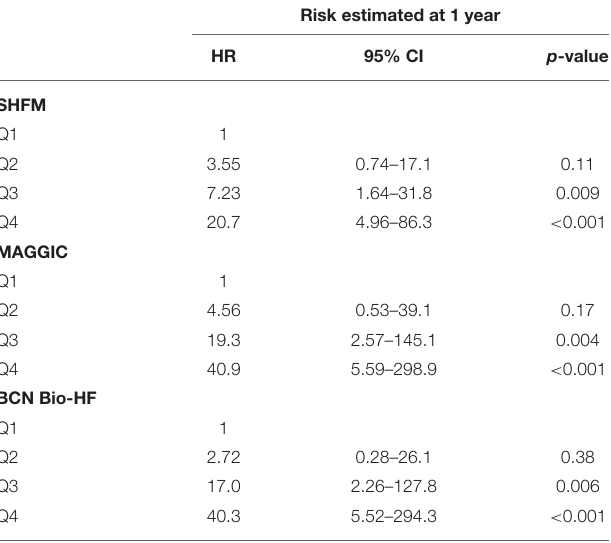
TABLE 4 | Cox regression based on quartiles of the risk estimated at 1 year.